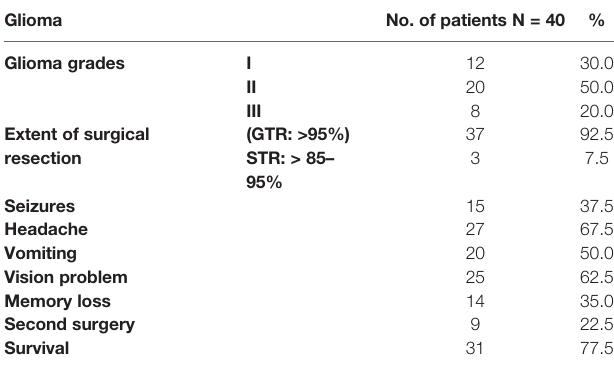
TABLE 1 | Clinicopathologic characteristics of collected glioma